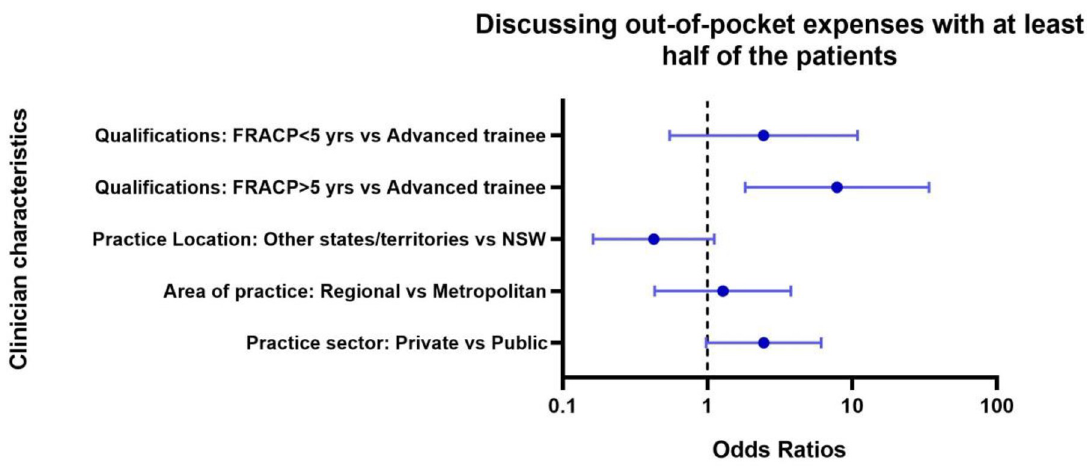
Fig 3. Characteristics associated with reported frequency of discussions of out-of-pocket costs with patients. � FRACP = Fellow of Royal Australasian College of Physicians.